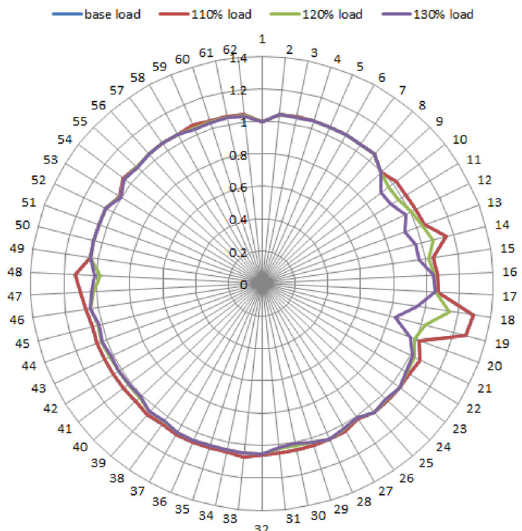
Fig. 8 Bus voltage profile under different loading conditions